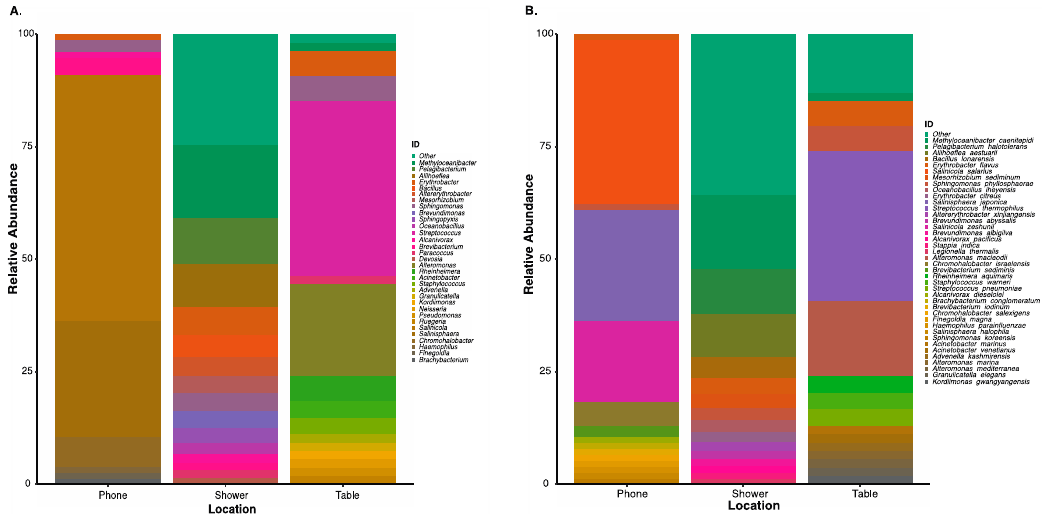
Figure 3. Microbial profile of the top 15 ( A ). genus and ( B ). suggested species level identifications from three distinct locations onboard the Aquarius habitat by NASA Extreme Environment Mission Operations (NEEMO) 22 crew using the culture-independent, swab-to-sequencer method. Alignments performed using minimap2 (-ax map-ont).